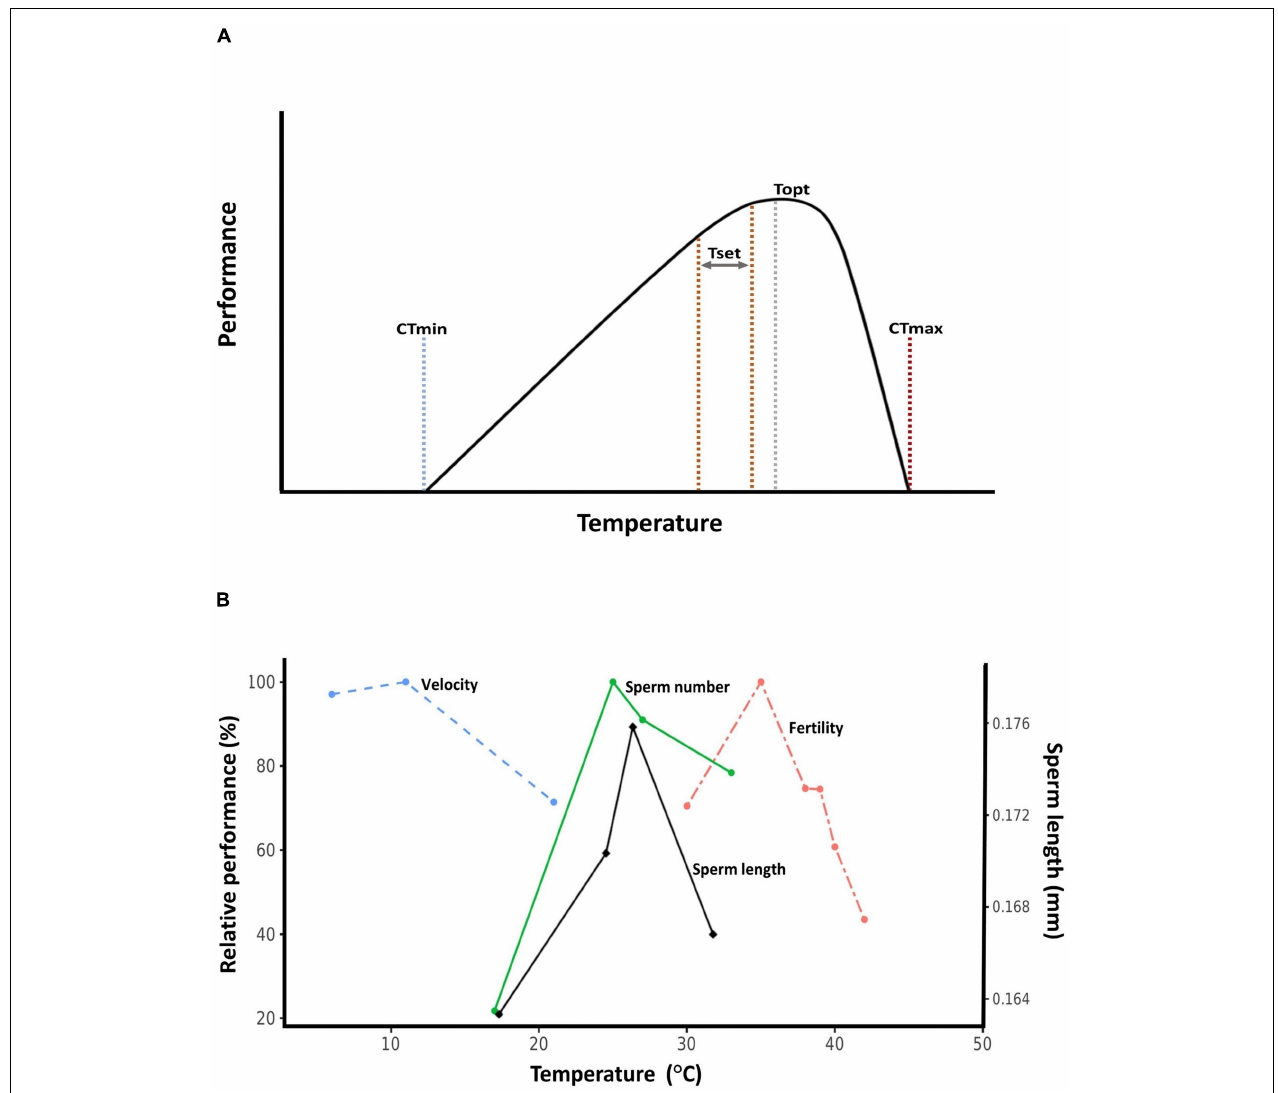
FIGURE 1 | Thermal performance curves. (A) Hypothetical thermal performance curve. CTmin: critical thermal minimum, the cold tolerance limit. CTmax: critical thermal maximum, the heat tolerance limit. Set point range (Tset): also known as the preferred temperature range, this is the target range of body temperatures ectothermic organisms seek out in a thermally variable environment. Topt: thermal optimum, the temperature at which performance is maximized. (B) Relative thermal performance (maximum value set to 100%) of ejaculated sperm velocity (Atlantic cod, Gadus morhua , Purchase et al., 2010), developmental sperm length (bruchid beetle, Callosobruchus maculatus , Vasudeva et al., 2014), sperm number (bruchid beetle, C. maculatus , Vasudeva et al., 2014), and male fertility (red flour beetle, Tribolium castaneum , Sales et al.,